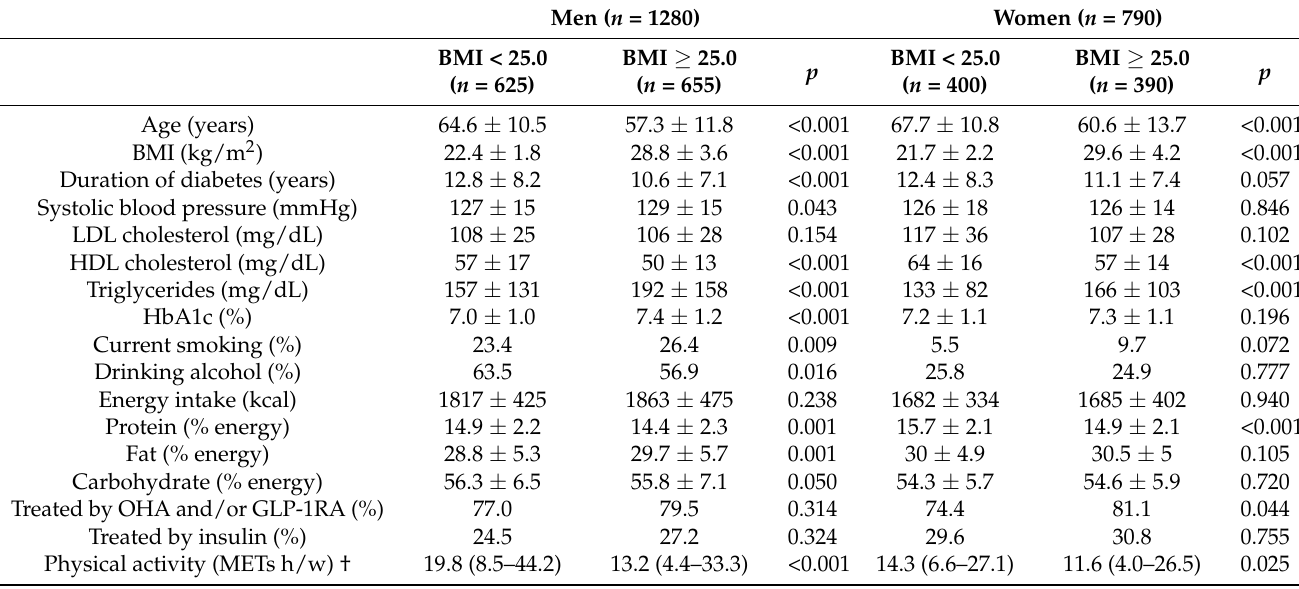
Table 1. Characteristics of